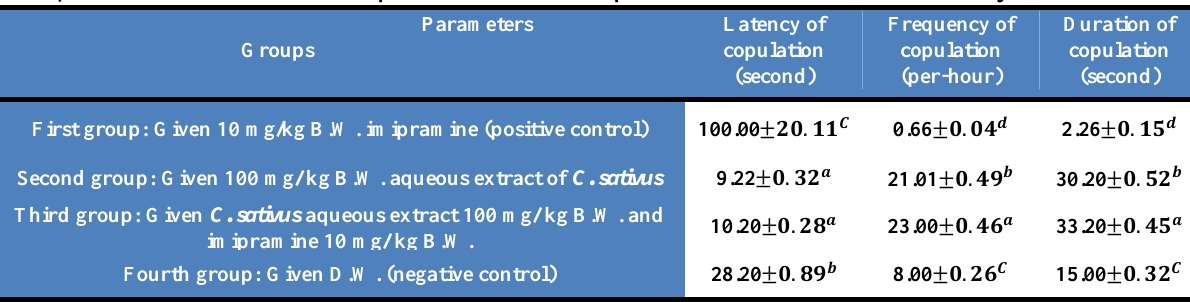
Table, 2: Effects of aqueous extract of Crocus sativus and imipramine on luteinizing and testosterone hormones in male mice. Hormonal levels Groups